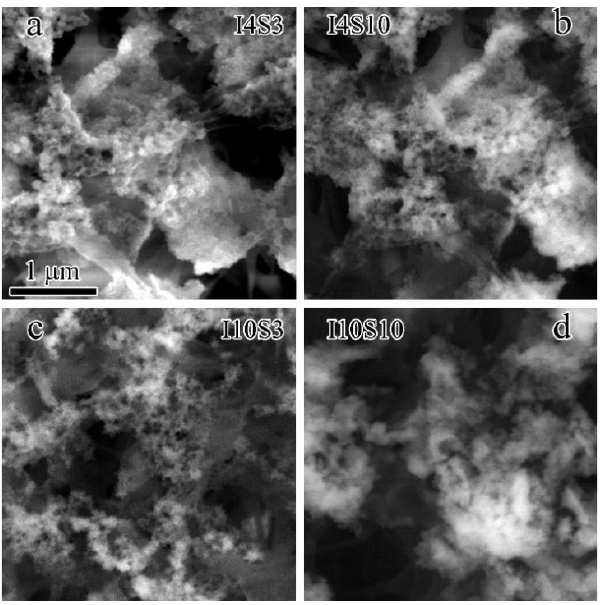
Figure 8. The SEM images of specimens recycled from NaCl electrolyte. ( a ) I4S3; ( b ) I4S10; ( c ) I10S3; ( d ) I10S10.